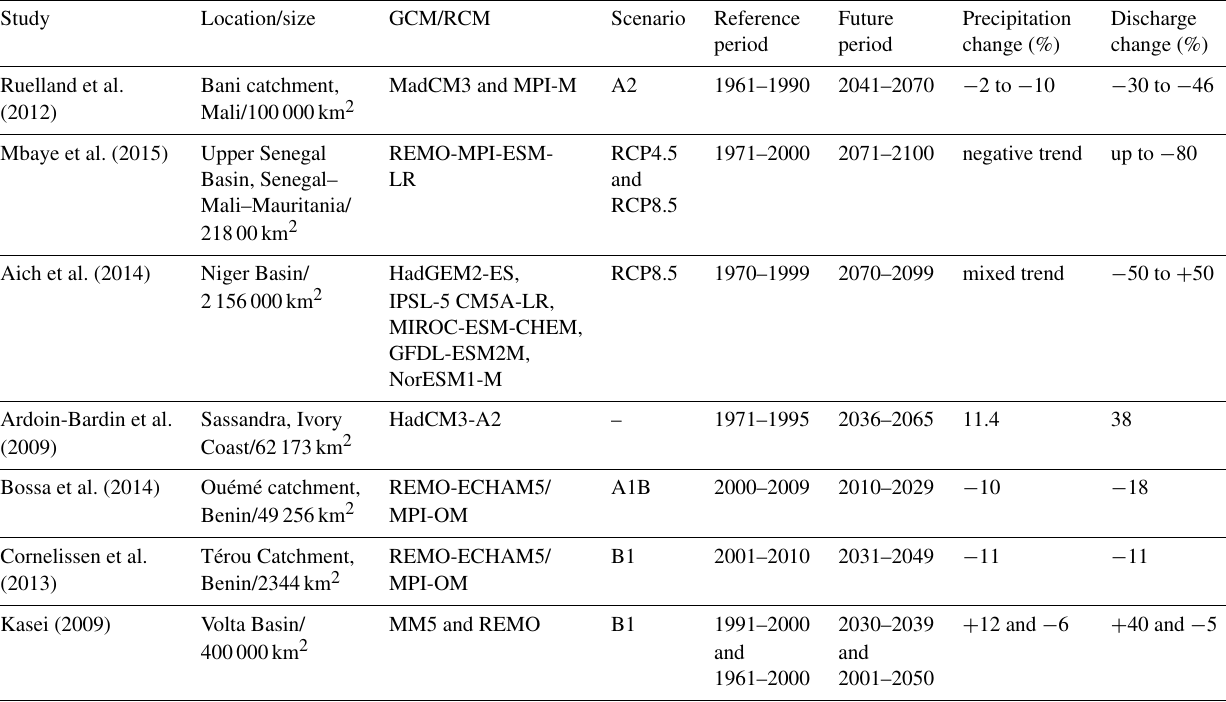
Table 7. Selected studies of climate impact on water resources in the West African region. Study Location/size GCM/RCM Scenario Reference Future Precipitation period period change